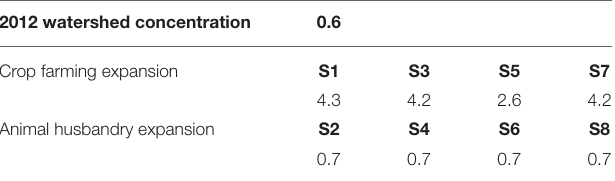
TABLE 4 | Concentration of total nitrogen in watershed outflow (mg/L). 2012 watershed